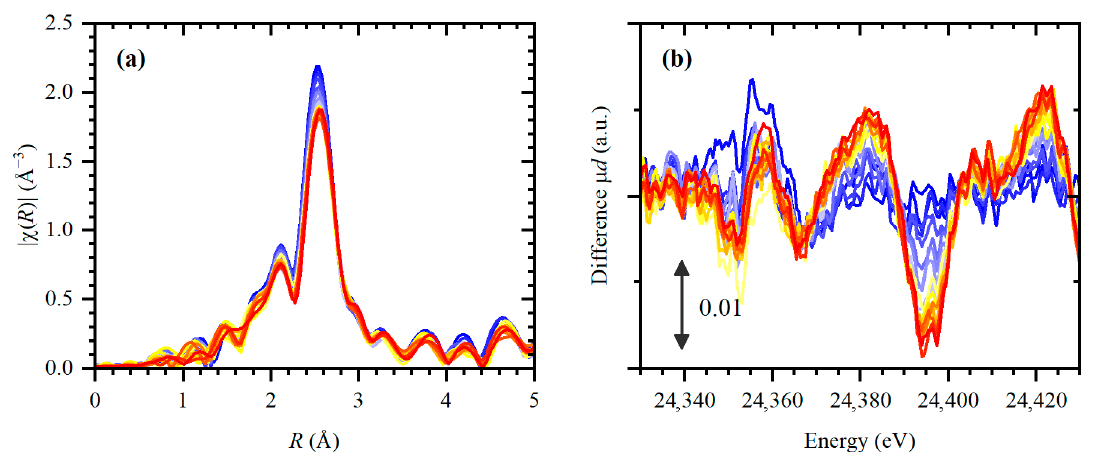
Figure 1. ( a ) Experimental FT-EXAFS spectra (phase uncorrected) and ( b ) difference XANES spectra (obtained by subtracting a spectrum of metallic Pd NPs) collected during exposure to ethylene at 50 °C (from blue to red) with the time step of ca. 10 min.